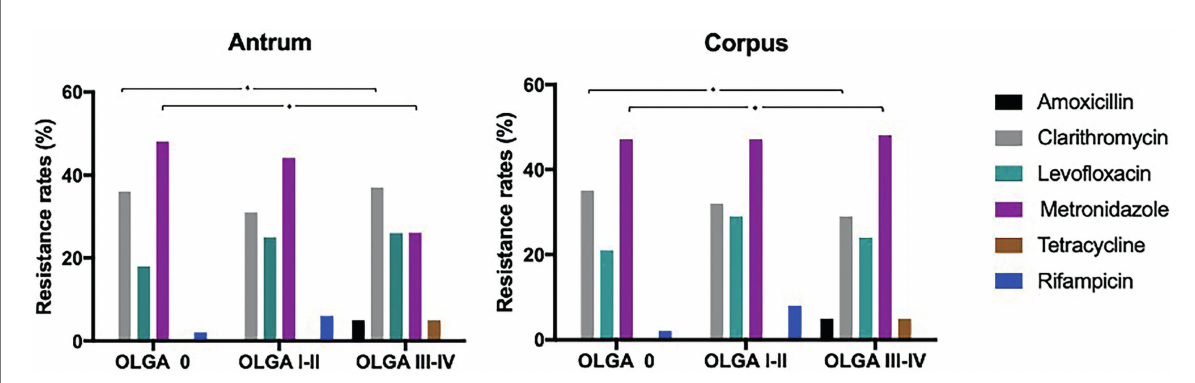
FIGURE 1 Distribution of resistance rate to amoxicillin, clarithromycin, metronidazole, levofloxacin, tetracycline, and rifampicin according to the different grade of atrophic gastritis (OLGA Stage 0, OLGA I–II, OLGA Stage III–IV) in the antrum and corpus. OLGA: Operative Link for Gastritis Assessment. The Chi-square test of independence with a 95% confidence interval was used to detect differences in the proportion of patients with susceptible and resistant H. pylori strains. *Clarithromycin (Antrum: X 2 Pearson (4) = 1.82, p = 0.03, V Cramer = 0.00, Cl 95% 0.00–1.00; corpus: X 2 Pearson (4) = 3.48, p = 0.01, V Cramer = 0.00, Cl 95% 0.00–1.00) *Metronidazole (Antrum: X 2 Pearson (2) = 4.95, p = 0.0098, V Cramer = 0.18, Cl 95% 0.00–1.00; Corpus: X 2 Pearson (2) = 0.62, p = 0.02, V Cramer = 0.00, Cl 95%